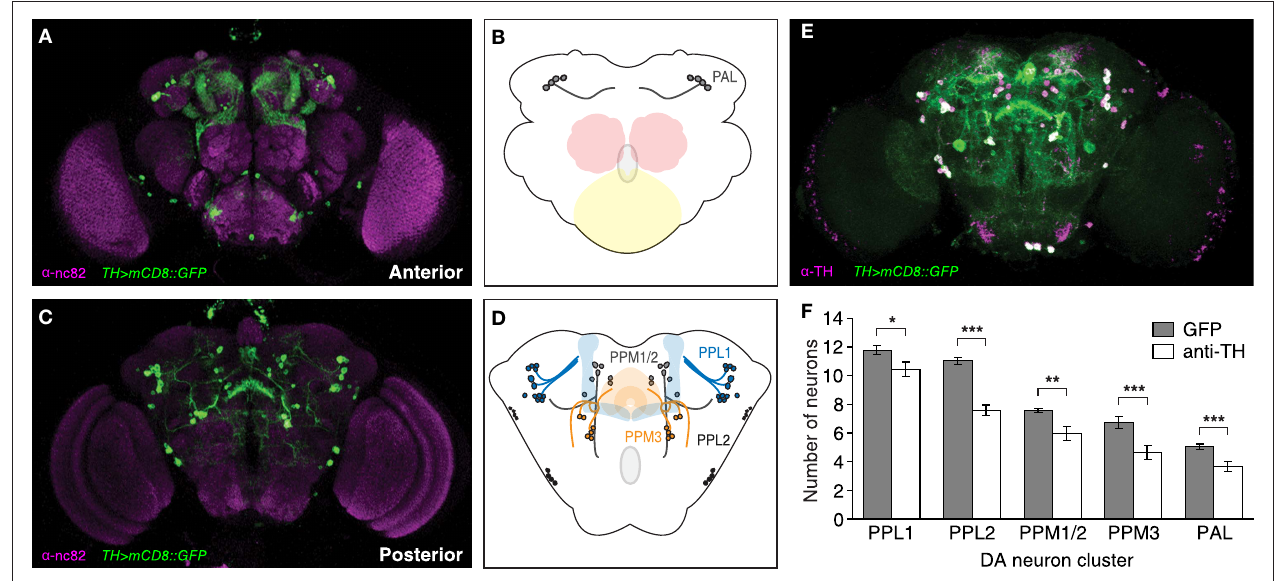
Figure 1 | Dopaminergic neurons in the adult Drosophila brain define distinct clusters which comprise defined numbers of cells. (A–D) Confocal Z-stack of TH > mCD8 :: GFP brain; anti-nc82 immunoreactivity together with GFP labeling reveals dopaminergic neurons in the anterior (A,B), and posterior (C,D) brain. DA neurons can be grouped into the PAL cluster (B) , which is located superior to the subesophageal ganglion (yellow) and the antennal